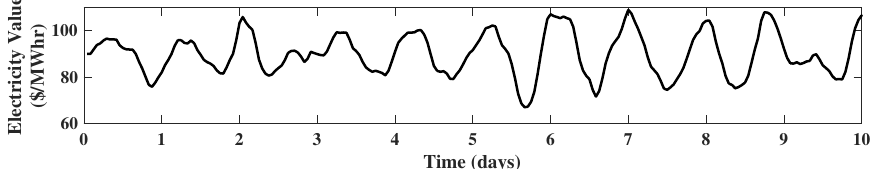
Figure 2. A realization of the stochastic process used to model electricity